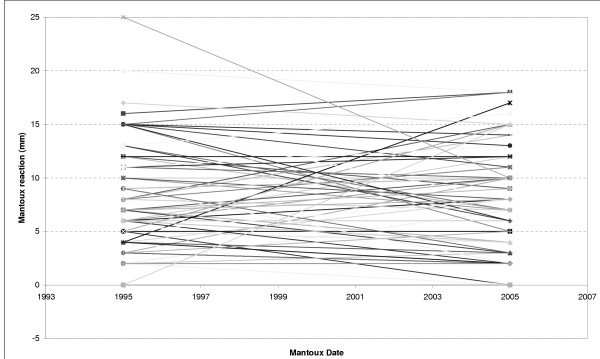
Follow up of recent individual indurations (2005) correlated to initial Mantoux values (10-year time interval)